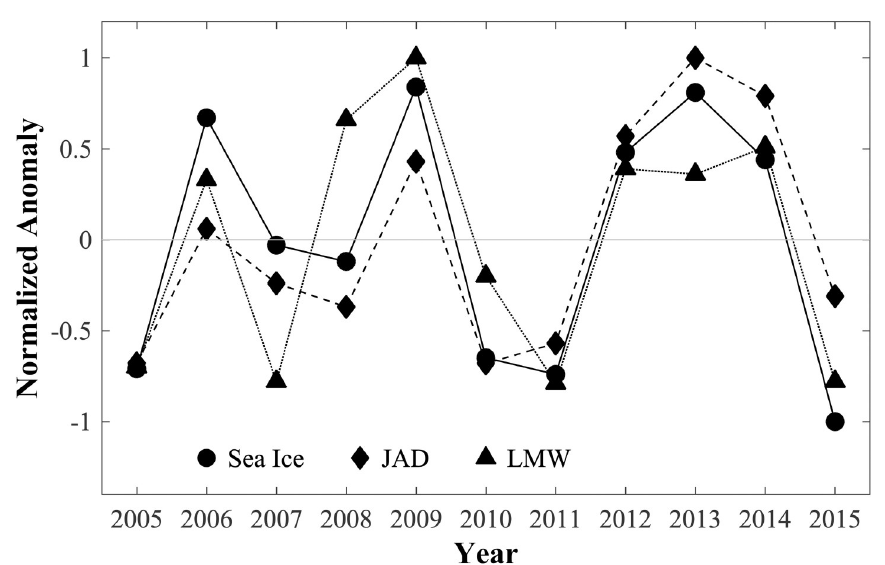
Fig 5. Annual normalized anomalies from the 11-year mean for May 31 st Chukchi Sea ice extent (sea ice), late season melt water (LMW) volume, and the proportion of combined juvenile and adult krill of total krill (JAD). LMW volume from Okkonen et al . [5]. Actual anomalies normalized to the maximum of the absolute values of the anomalies for each variable within the 11-year record.